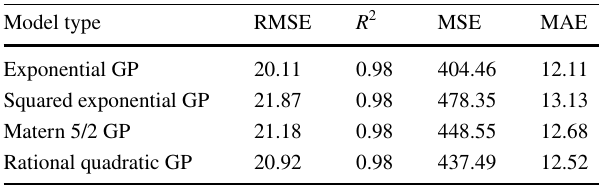
Table 4 Summary of the results of the Monte Carlo simulated GP